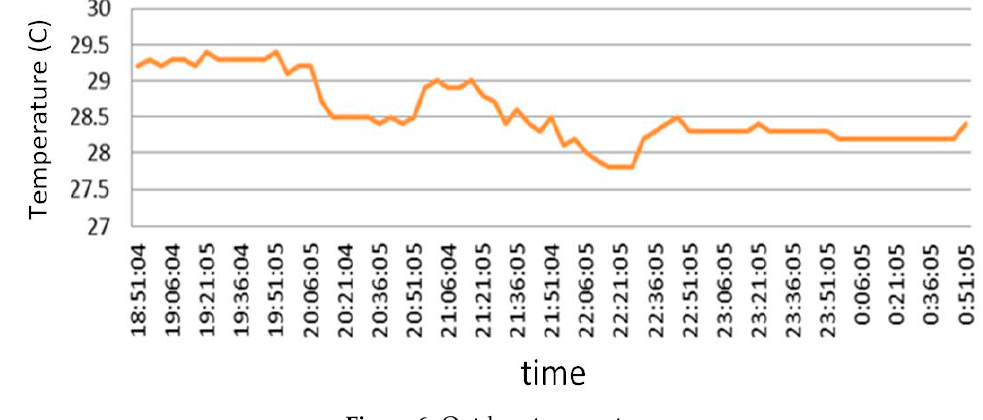
Figure 6. Outdoor temperature.